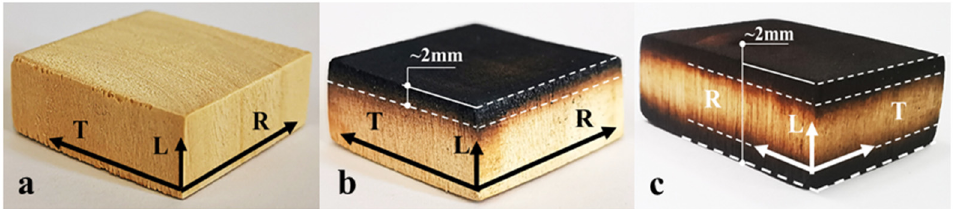
Figure 1. Processing diagram of the specimens. ( a ) Cross-section of untreated poplar; ( b ) cross-section of single-sided carbonized 2 mm poplar; ( c ) cross-section of double-sided carbonized 2 mm poplar. After the previously mentioned treatments, five uncarbonized, single-sided carbonized, and double-sided carbonized specimens were prepared. The untreated poplar was labeled NCP, the single-sided carbonized poplar SCP, the double-sided carbonized poplar DCP, and the fully carbonized poplar as FCP; L, C, R, and T represent the longitudinal, cross, radial, and tangential sections,